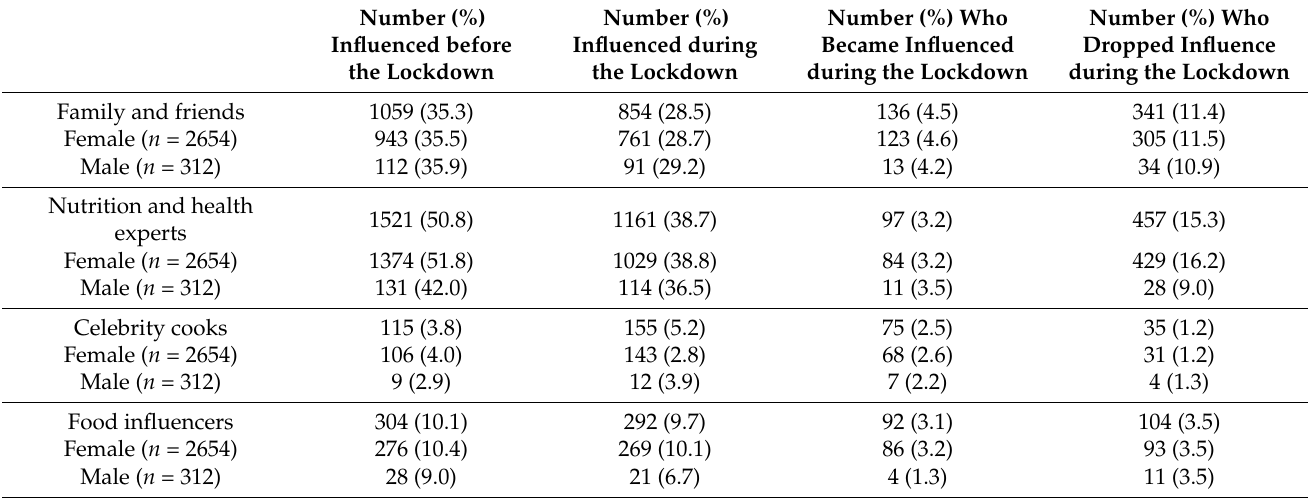
Table 1. Number (%) of participants according to reported food and cooking inspiration sources before and during the lockdown ( n = 2997).